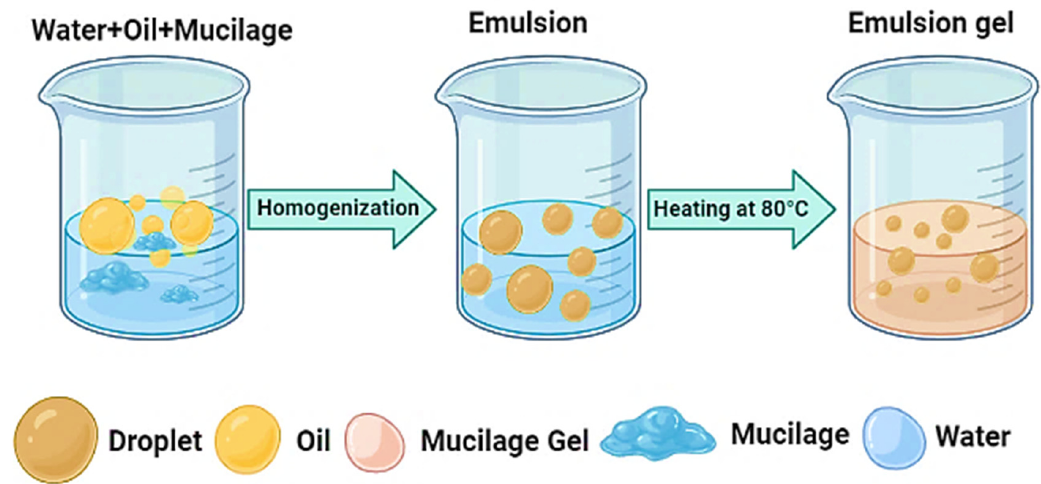
Figure 3. Proposed mechanism of emulsifying action of taro mucilage.